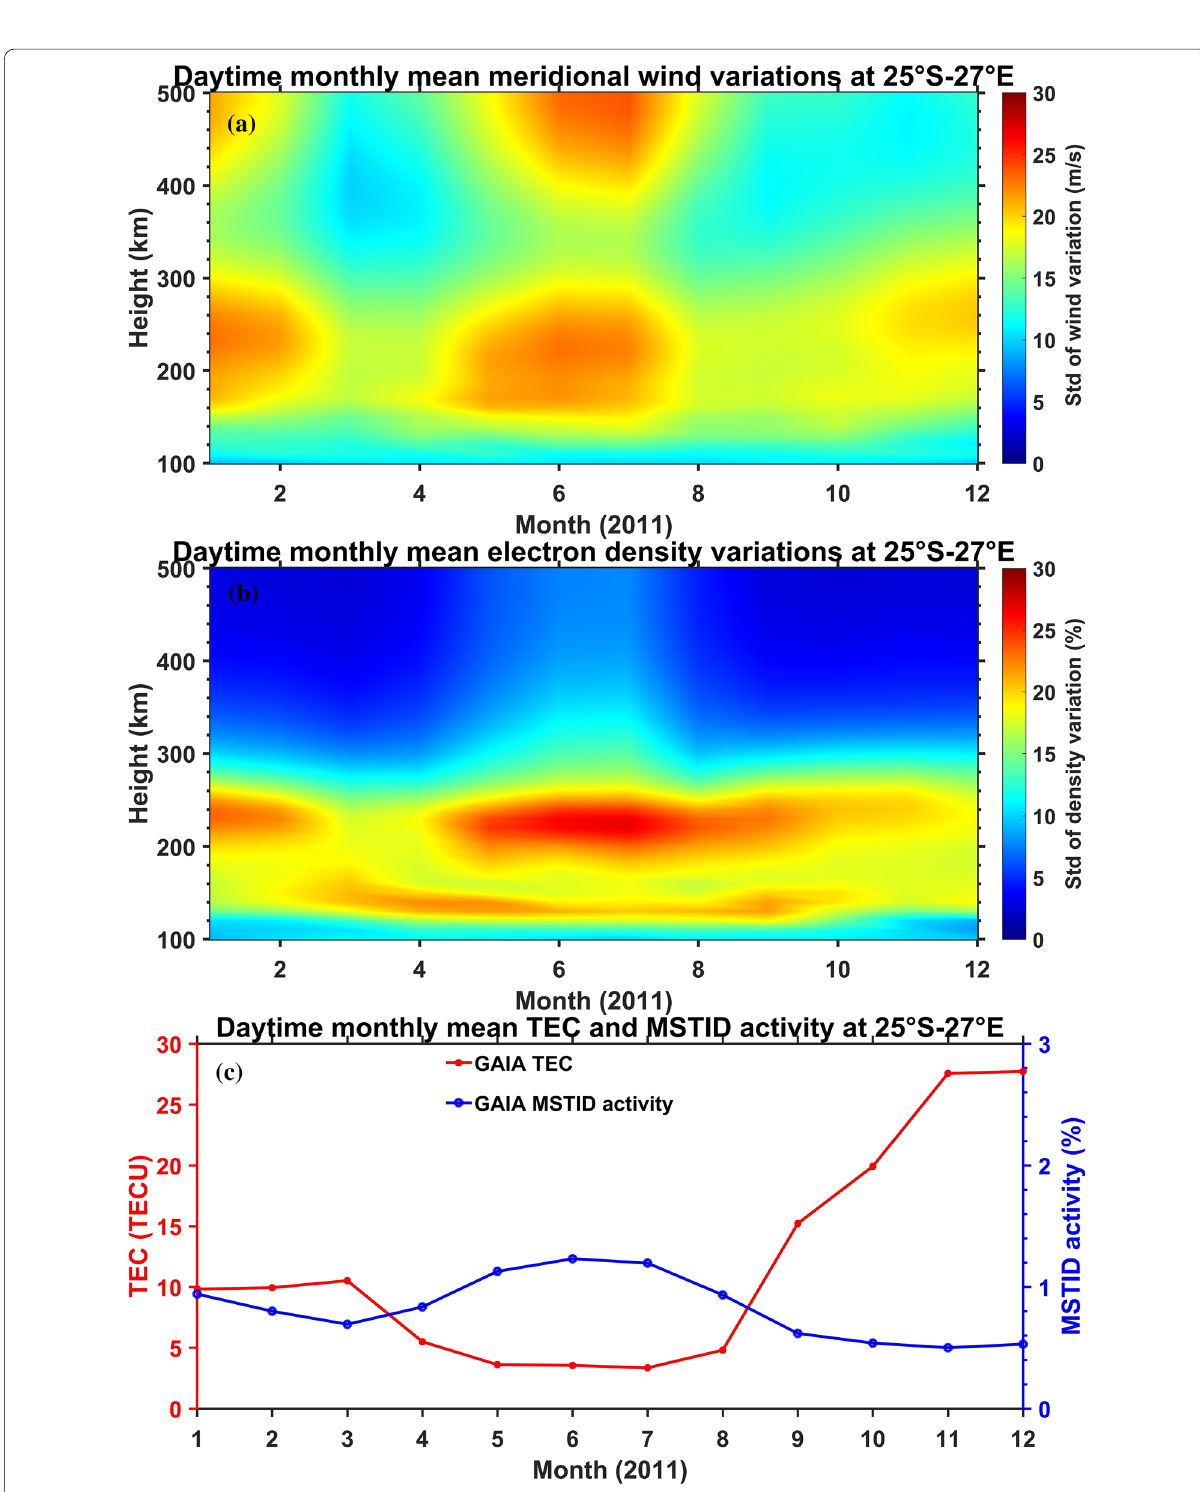
Fig. 8 Altitude and seasonal variations of the daytime (09:00–15:00 LT) monthly mean standard deviation of (top) meridional wind variations and (middle) electron density variations over the South African (25° S, 27° E) for the year 2011. Bottom panel show daytime time monthly mean TEC and MSTID activity over South Africa in the same